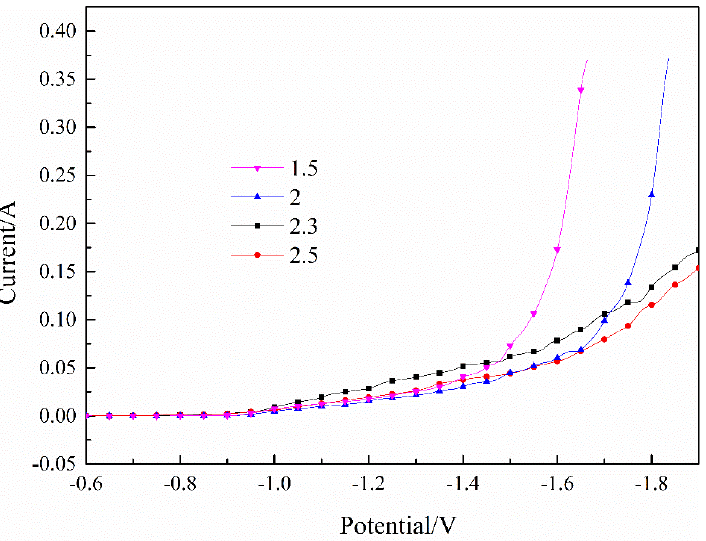
Figure 3. Effect of pH value on the Fe – Ni co-deposition process. T = 30 °C.